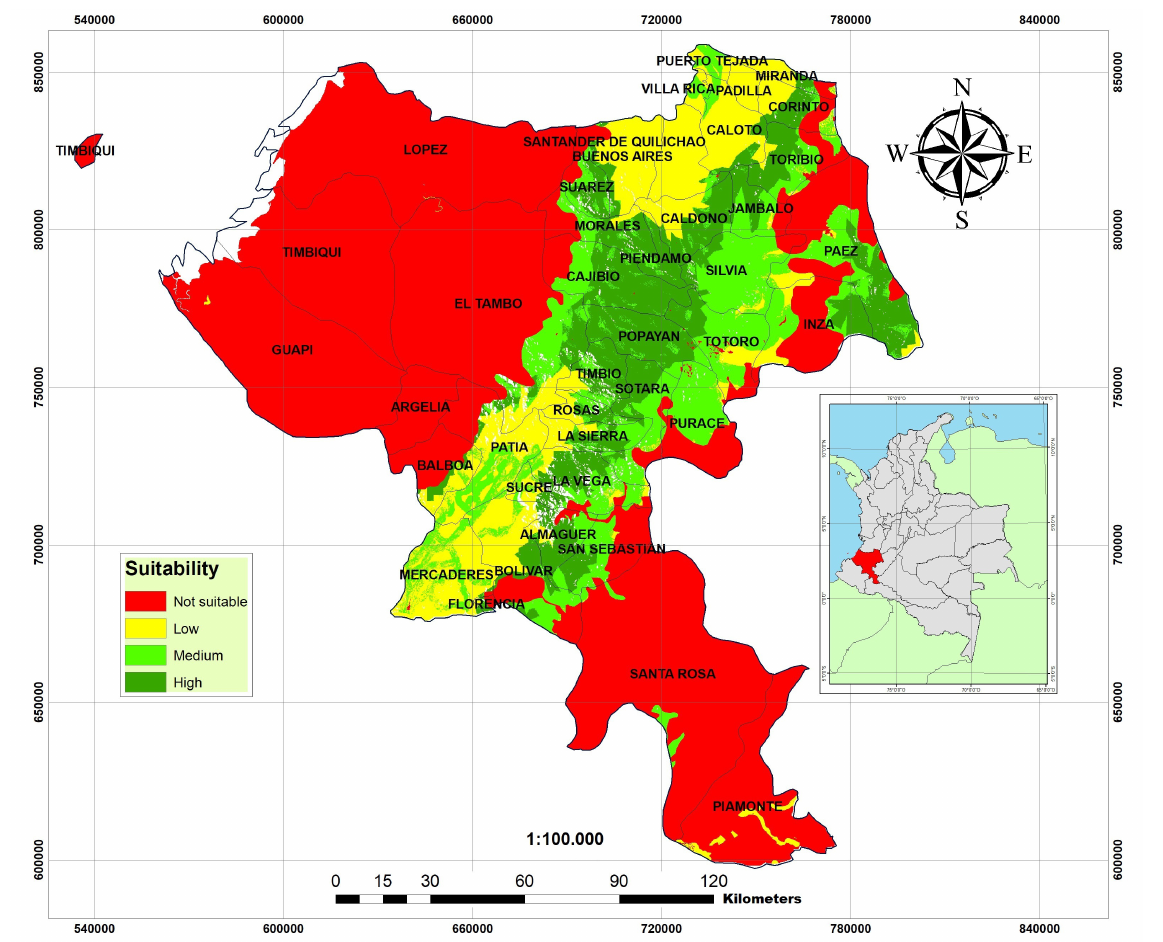
Figure 3. Consolidated map of suitable levels of zones to grow Hass avocado in the Cauca